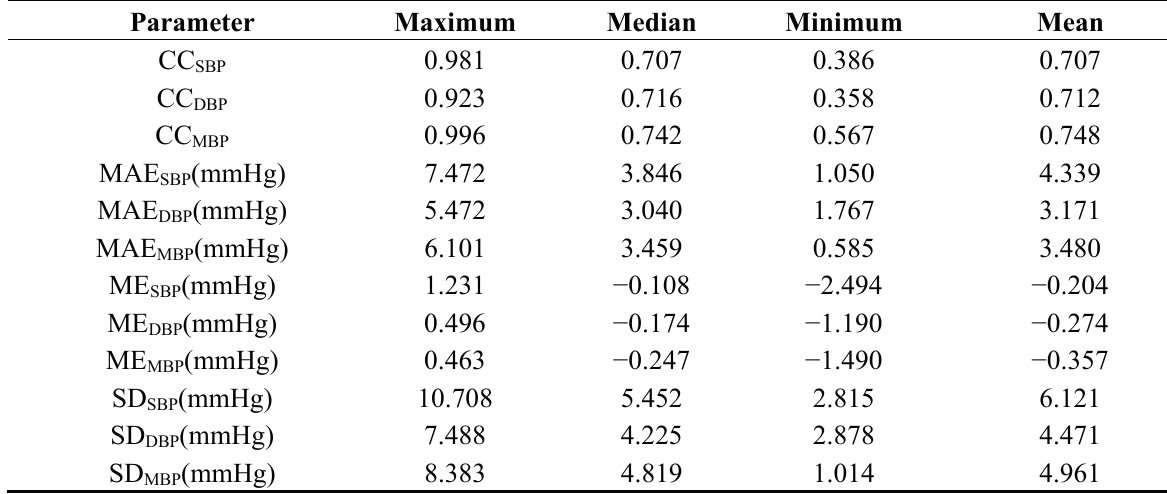
Table 1 . Distributions of the statistical parameters among all the subjects. Parameter Maximum